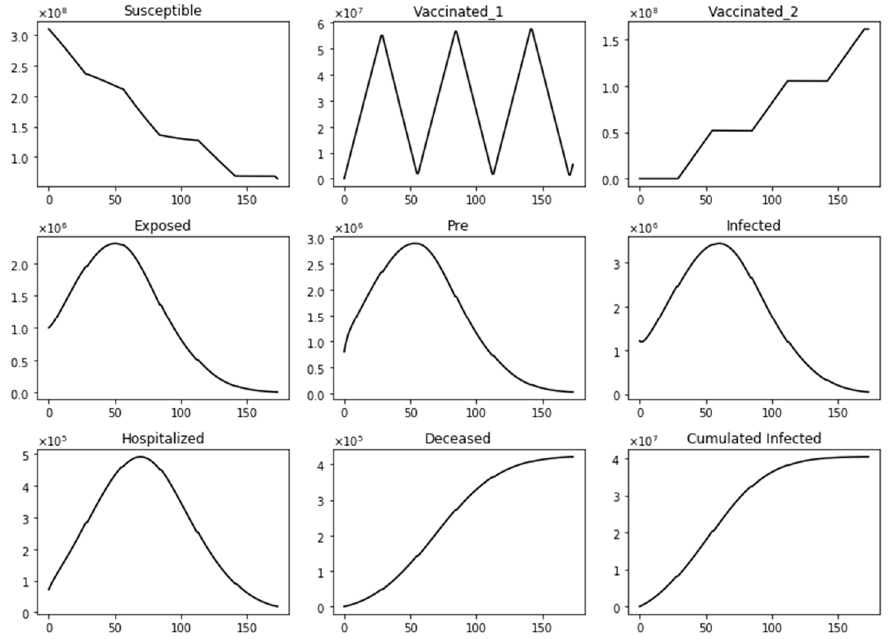
Figure 2. Dynamics of several subpopulations under a standard vaccine regimen of 4 weeks between doses. This scenario considers a transmission rate such that the basic reproduction number R 0 is greater than one, the vaccination pace is 2 million per day, and the vaccine efficacy after the first dose is 60% and 95% after the second dose.